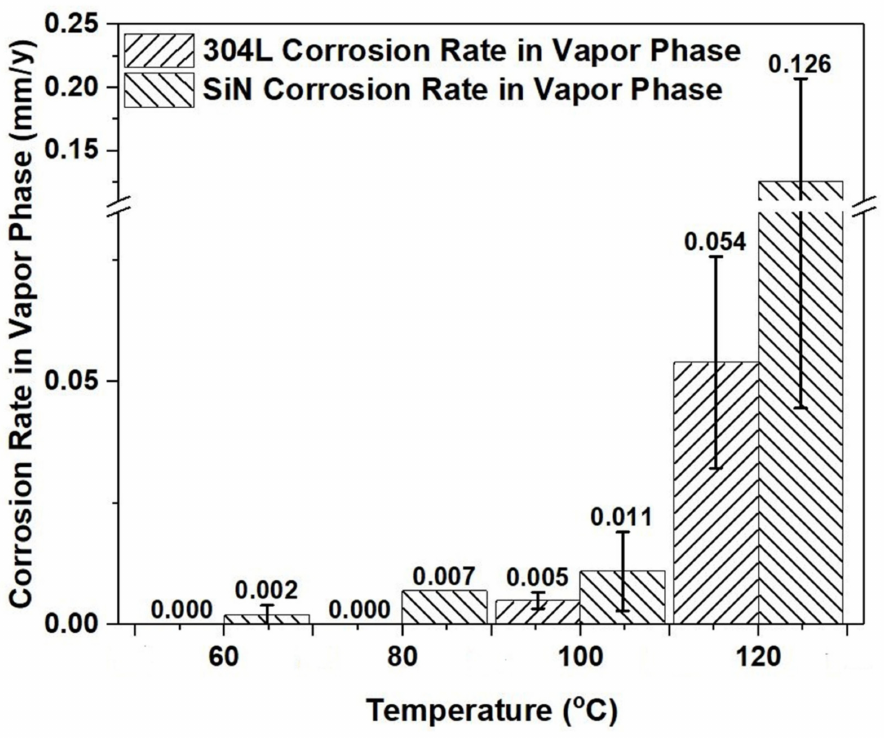
Figure 8. Corrosion rates of SiN and 304L stainless steel in nitric acid vapor phase at different